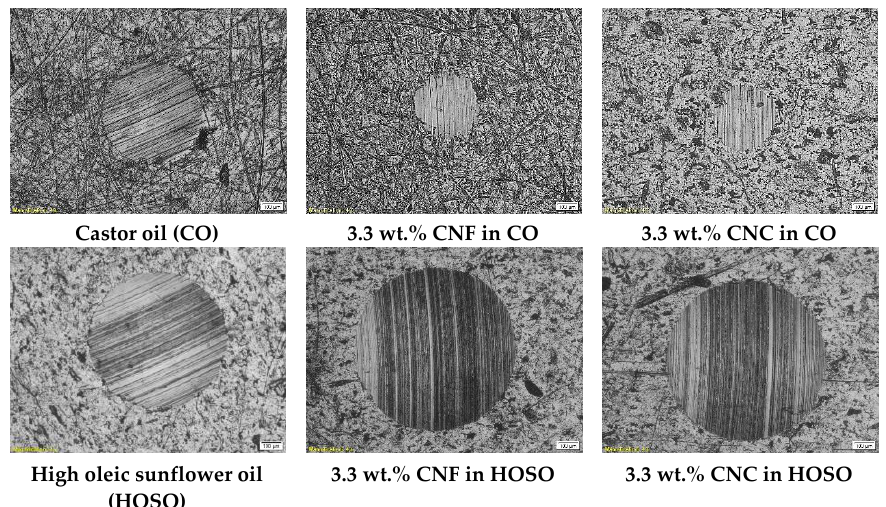
Figure 9. Comparative evaluation, as a function of base oil used (neat CO or neat HOSO), of wear scar diameter from wear tests performed on neat oil ( left column ), 3.3 wt.% CNF ( middle column ) and 3.3 wt.% CNC ( right column ).